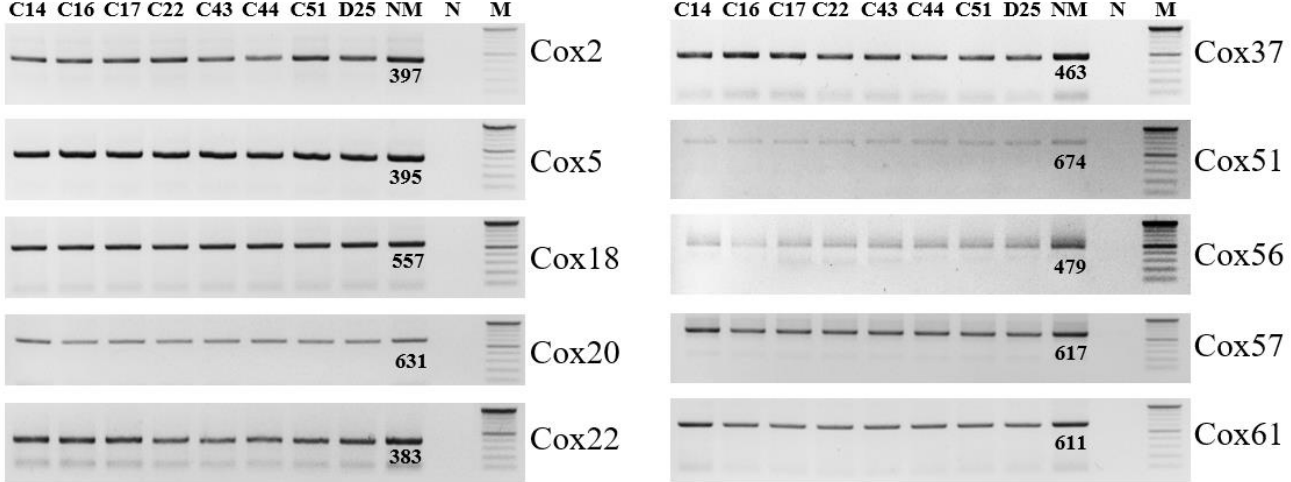
Figure 4. Amplification of 10 spacers for MST analysis. The 10 spacers, including Cox2, Cox5, Cox18, Cox20, Cox22, Cox37, Cox51, Cox56, Cox57, and Cox61, were amplified from eight vaginal swab samples: C14, C16, C17, C22, C43, C44, C51, and D25. “NM” is the Nine Mile strain with amplicon size (in base pair long) of each marker is shown, “M” is 100 bp DNA marker, and “N” is negative control without DNA template.